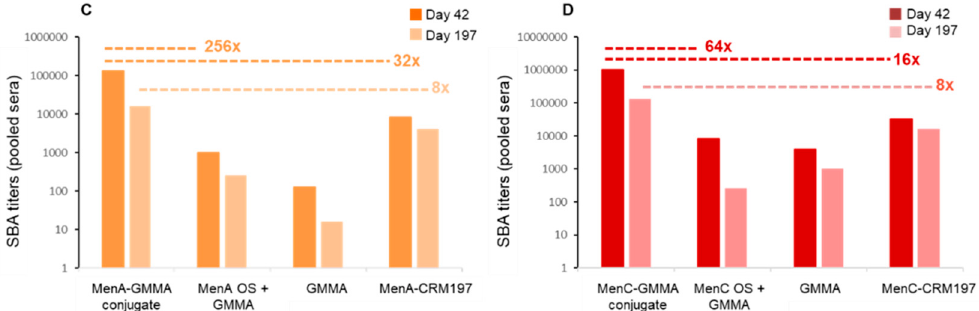
Figure 3. GMMA as a carrier for polysaccharides compared to traditional CRM197 conjugates. Eight